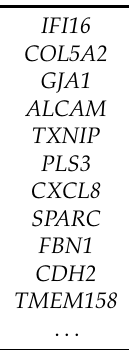
Table 3. miRmapper inputs. List of total differentially expressed genes; this is an optional